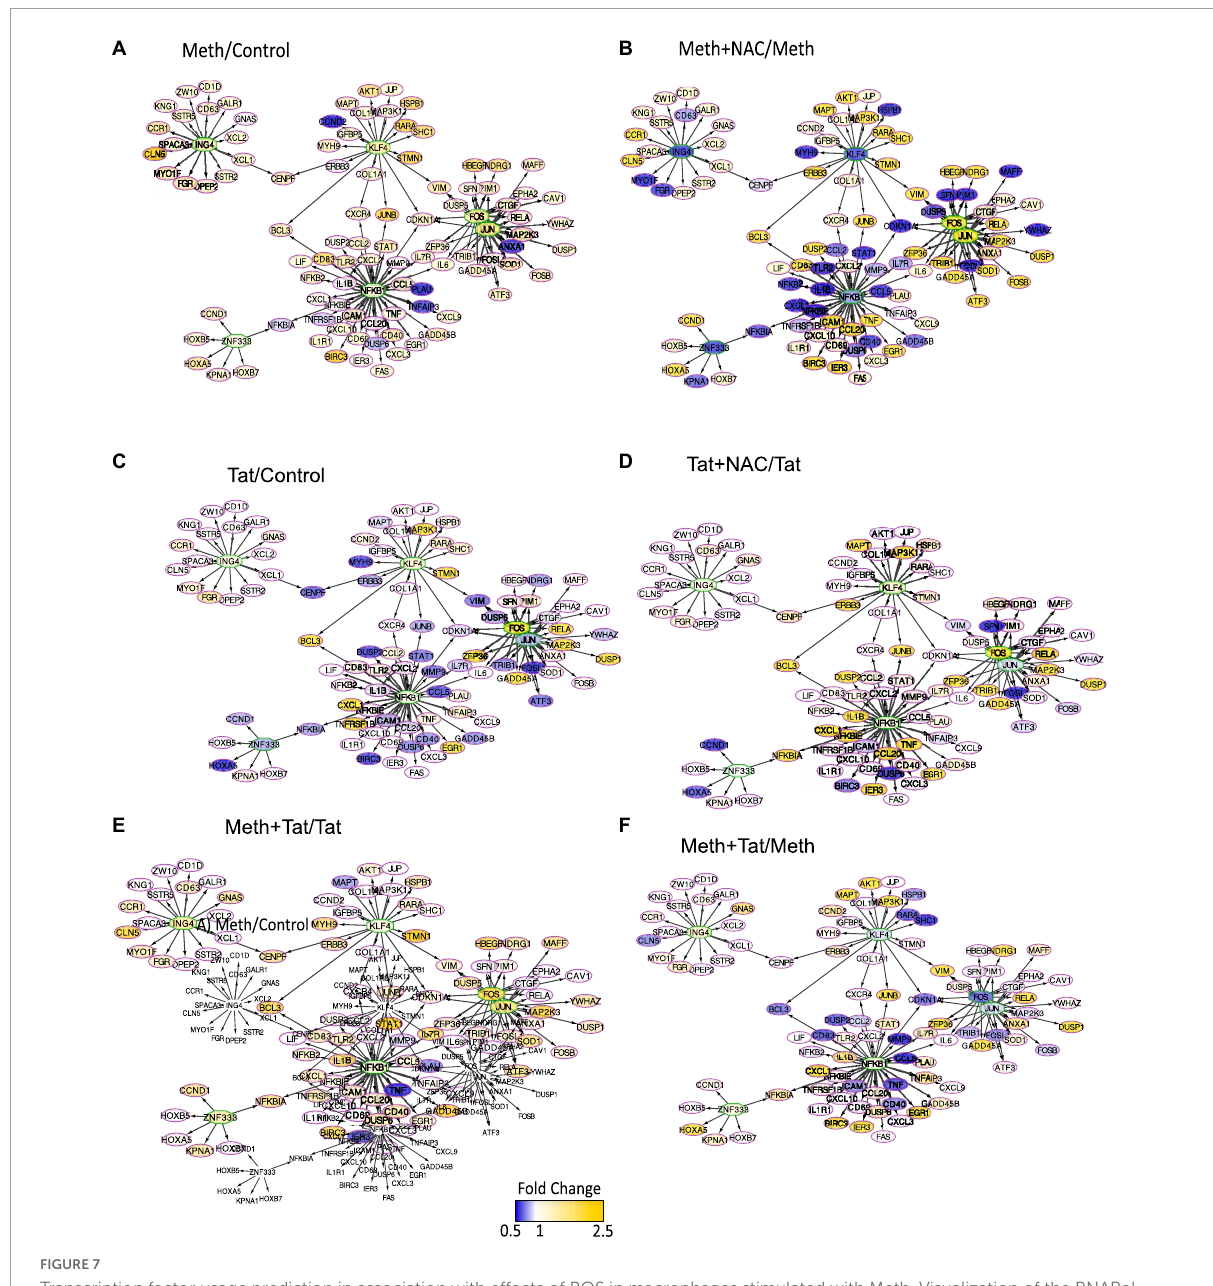
FIGURE7 Transcription factor usage prediction in association with effects of ROS in macrophages stimulated with Meth. Visualization of the RNAPol promoter recruitment changes in THP1 cells 15 min after stimulation with (A) Meth (60 uM) in relation to vehicle control, or (B) Meth + NAC in relation to Meth alone, (C) HIV Tat (10ng/ml) in relation to Control, (D) Tat + NAC in relation to Tat, (E) Meth + Tat in relation to Tat alone and (F) Meth + Tat in relation to Meth alone. TRANSFAC prediction was confirmed using merged iRegulon-predicted transcription factor megatargetomes, for visualization of significant ( p < 0.05) relative fold changes and cluster regulation. Predicted transcription factors, cFOS and cJUN (AP1), NFkB, ZNF333, KLF4, and ING4 positioned in the center of regulated gene clusters, and RNAPol recruitment to gene promoters is indicated by node colors, decreased in tones of blue and increased recruitment in tones of